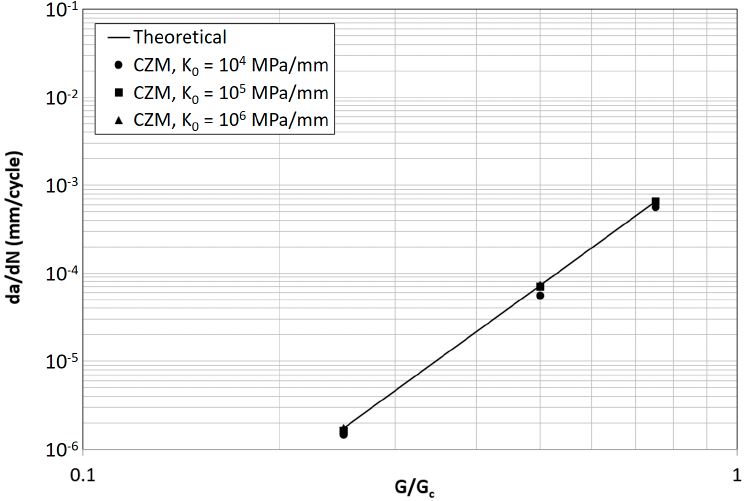
Figure 11. FCG rate as a function of G/G c for different values of K 0 ( σ 0 = 30 MPa).